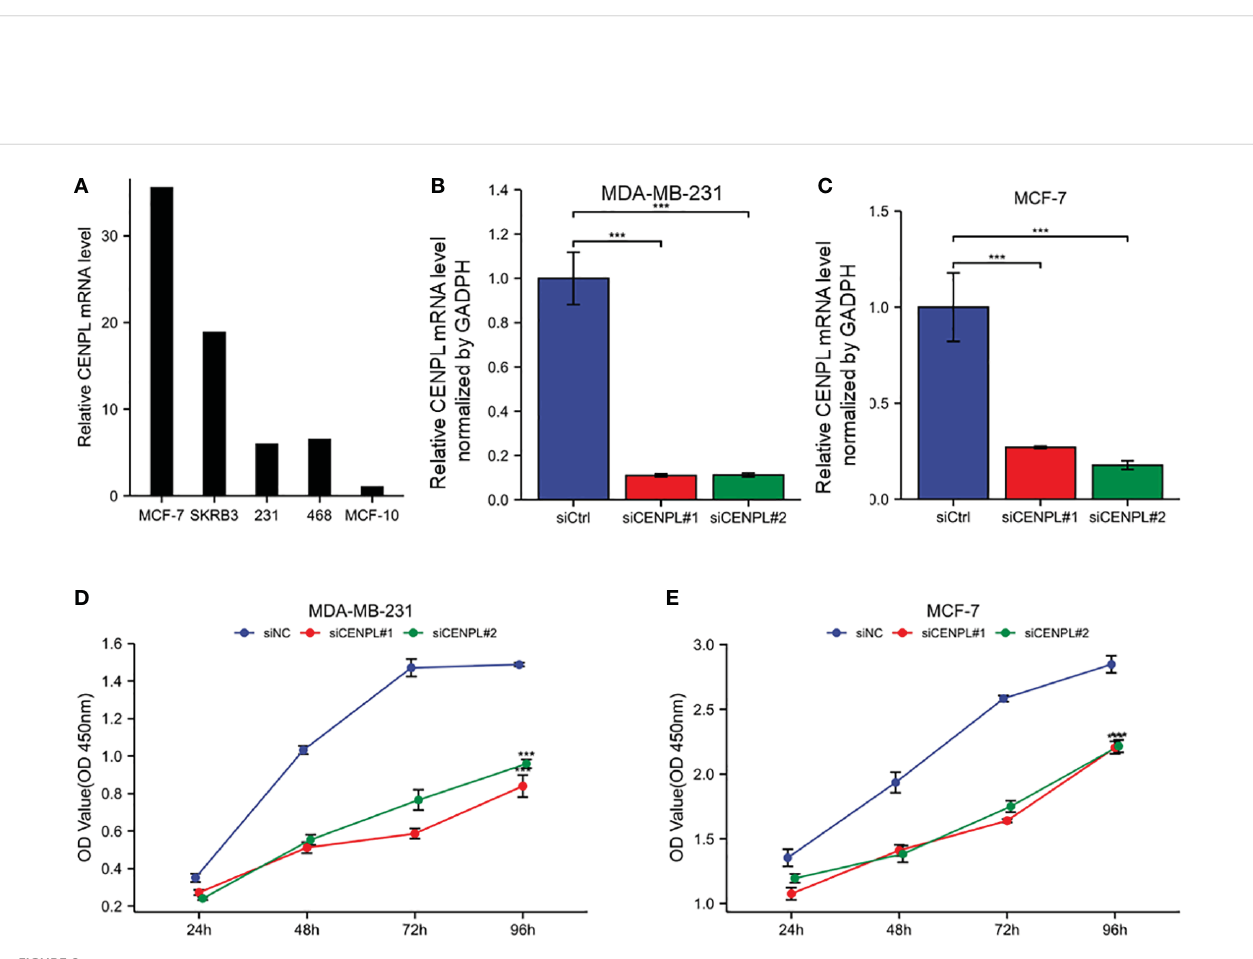
FIGURE 8 Expression and knockdown of CENPL in various cell lines and CCK8 cell proliferation experiment. (A) CENPL expression in MCF7, SKBRE3, MDA-MB-231, MDA-MB-468 and other breast cancer cell lines and MCF10A cell lines. (B) CENPL knockdown ef fi ciency of two SiRnas in MDA-MB-231 cell lines. (C) knockdown of two SiRnas in MCF7 cell lines Ef fi ciency of CENPL. (D-E) Cell proliferation in two siRNA knockout groups and control groups in MDA-MB- 231 and MCF7 cell